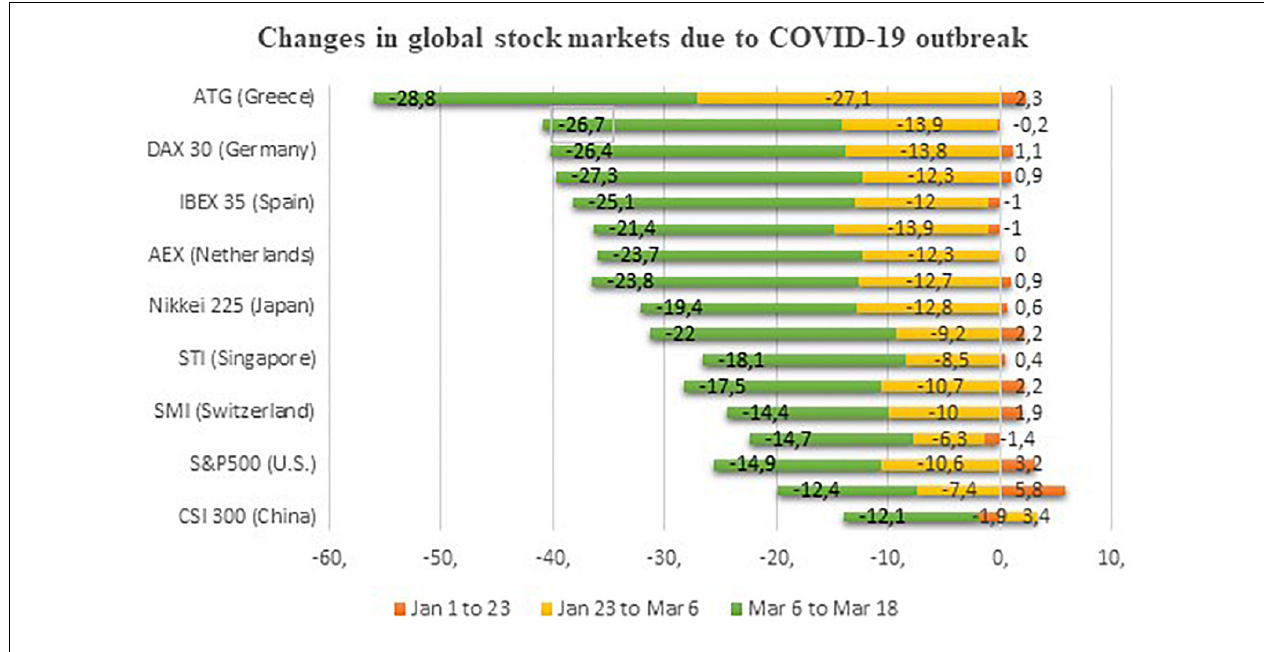
FIGURE 1 | Decline in financial markets due to COVID-19. Source: Statista